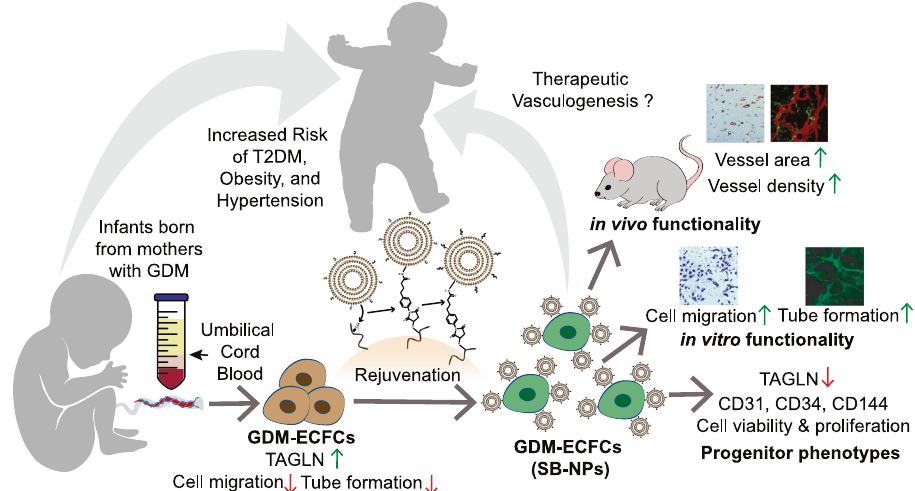
Fig. 7 Schematic representation of the cell surface conjugation strategy and functionality study. Children born from mothers with GDM experience increased risk of developing T2DM, hypertension, and cardiovascular disease later in life. Key to this enhanced risk is stress-induced dysfunction of vascular progenitor cells, including ECFCs. Cord blood-derived ECFCs isolated from patients with GDM overexpress TAGLN, demonstrate reduced cell migration, and exhibit impaired tube formation compared to normal ECFCs. Cell surface conjugation with bioactive nanoparticles enable pseudo-autocrine stimulation of GDM-ECFCs with SB-431542. Rejuvenation of GDM-ECFCs normalizes TAGLN expression, preserves key progenitor phenotypes, improves cell migration and tube formation in vitro, as well as augments the density and area of chimeric vessels formed in vivo. This cell surface conjugation strategy to rejuvenate GDM-ECFCs and improve their clinical potentials can be used for therapeutic vasculogenesis to address various complications precipitated from